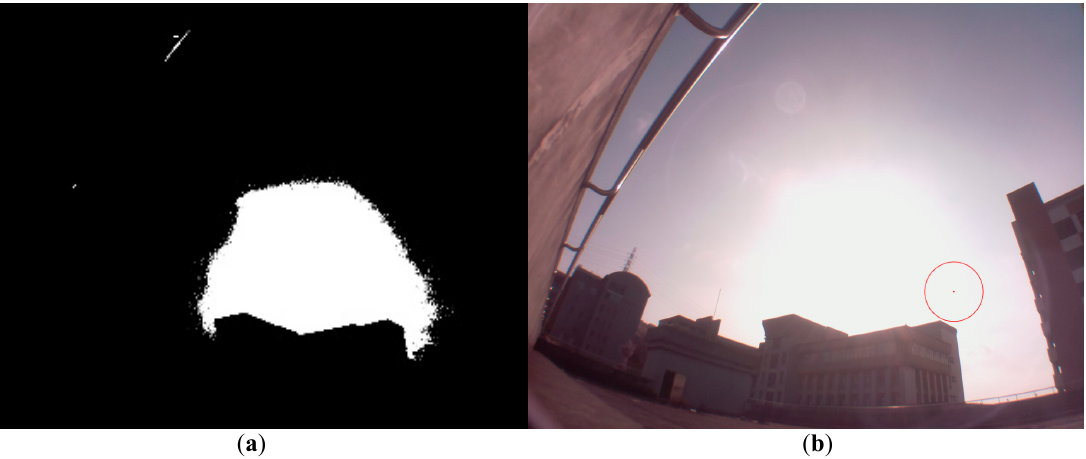
Figure 10. The related binary image is shown in ( a ); and the evaluated sun center by the Hough transform method is shown as a red point in ( b ).